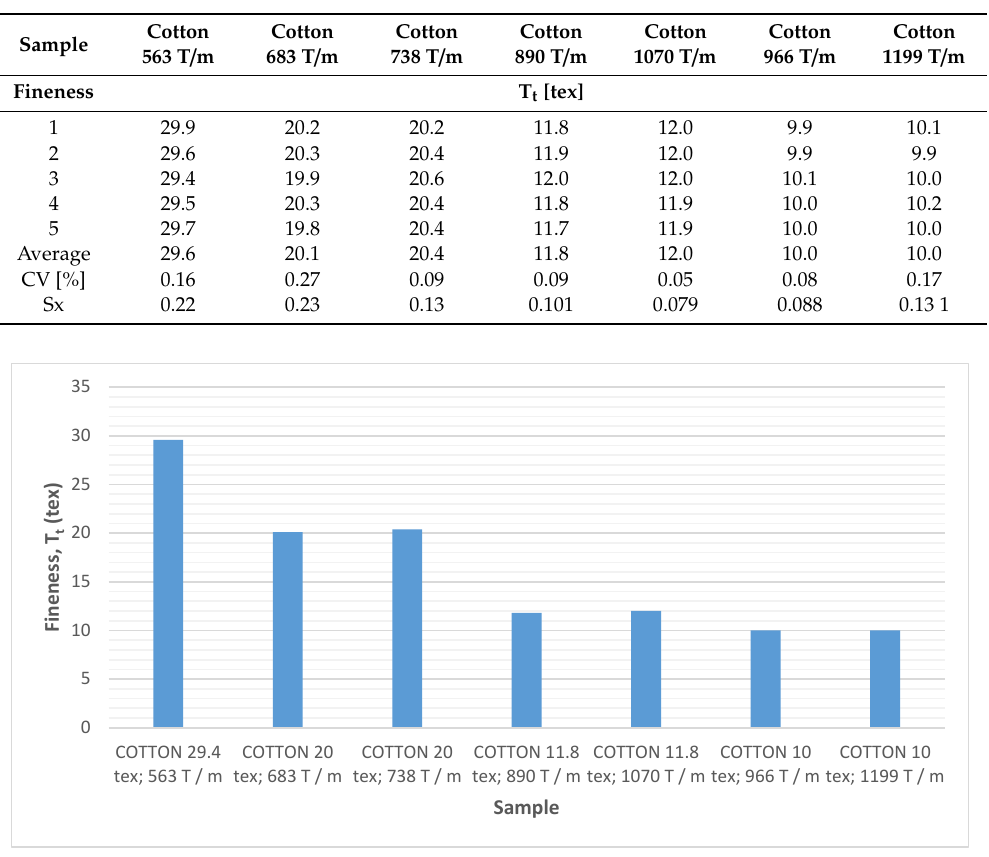
Table 5. Measured fineness of the analyzed yarns.